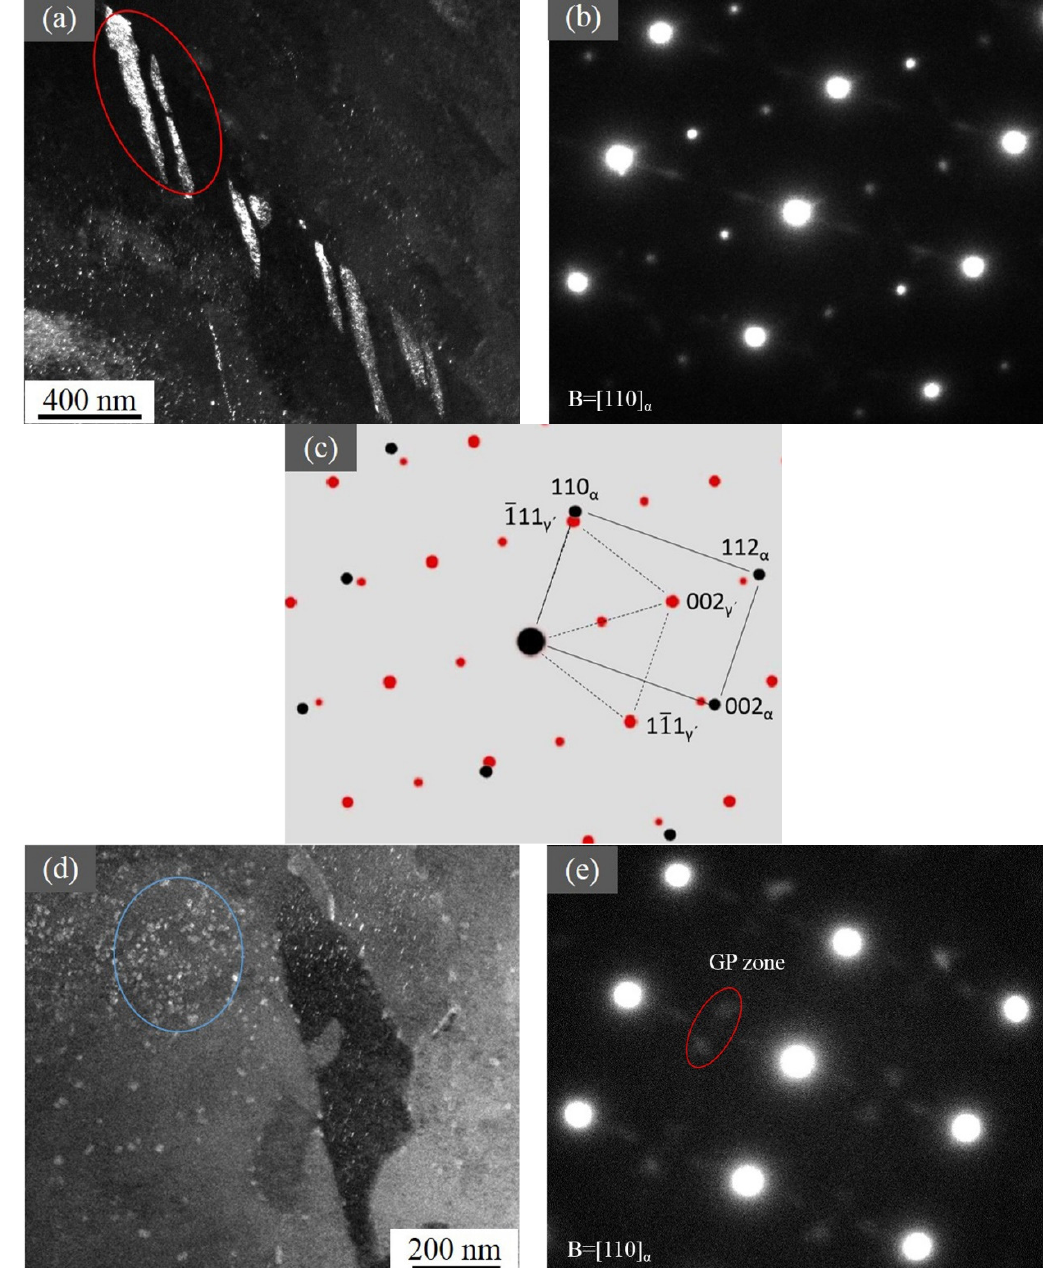
Figure 6. ( a ) TEM image of the nitrided steel at the depth of 40 µm, with Fe 4 N as marked by the red circle, and ( b ) the corresponding SAED (selected area electron diffraction) of Fe 4 N. ( c ) The illustration of ( b ). ( d ) Dark field image of GP zones and CrN as marked by the blue circle and ( e ) the SAED of them.